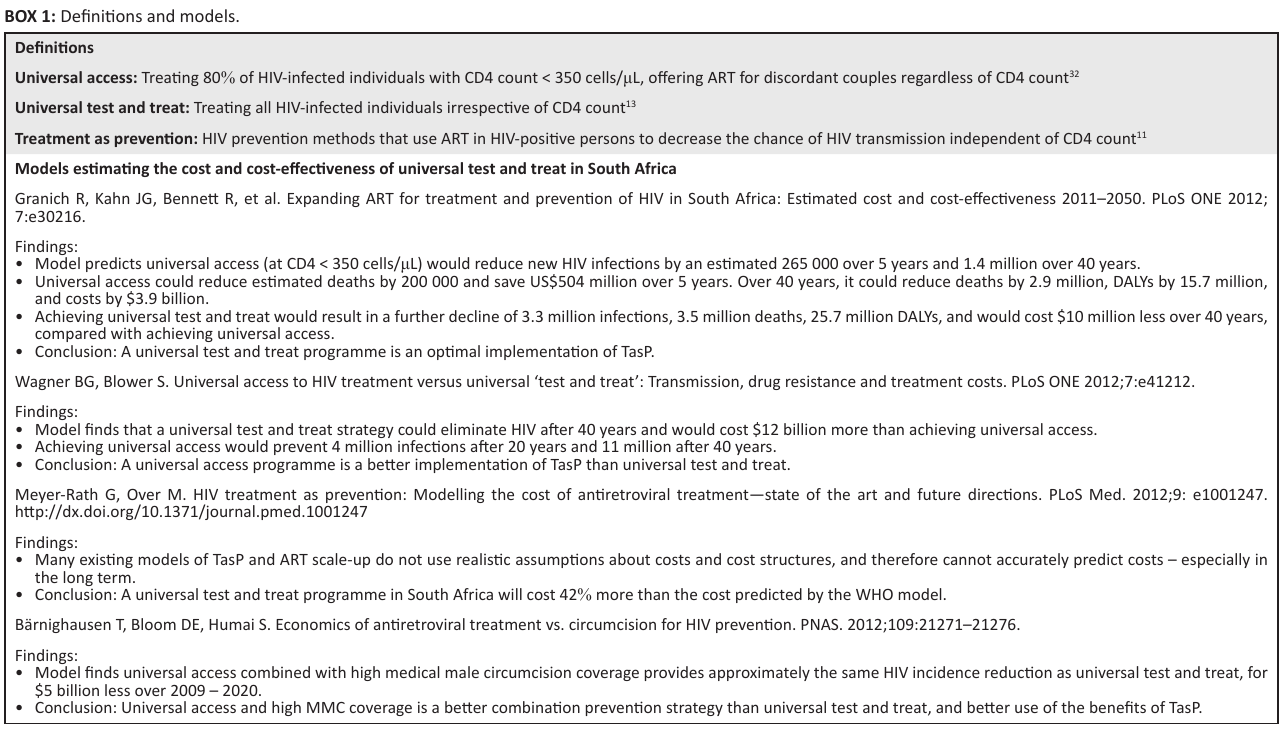
TABLE 1: Provincial